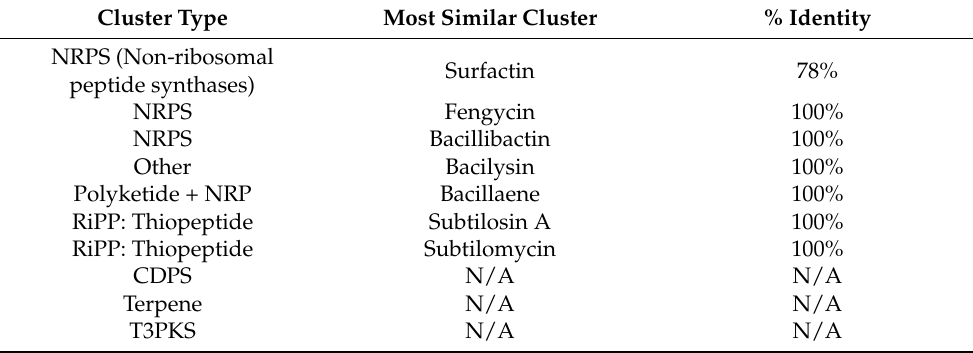
Table 3. Summary of secondary metabolite screening results for BS50 using antiSMASH.